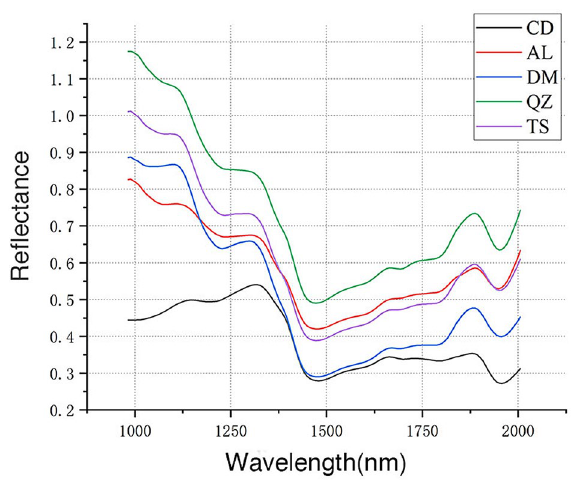
Figure 1. Mean spectra for the transverse section of samples. CD = G. conjugate ; AL = G. ehie ; DM = G. demeusei ; QZ = G. coleosperma ; TS = G. tessmannii